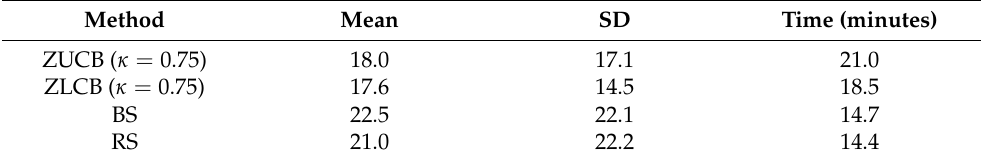
Table 4. Run number means and SDs, 100 runs in each case. Timings are in minutes for 100